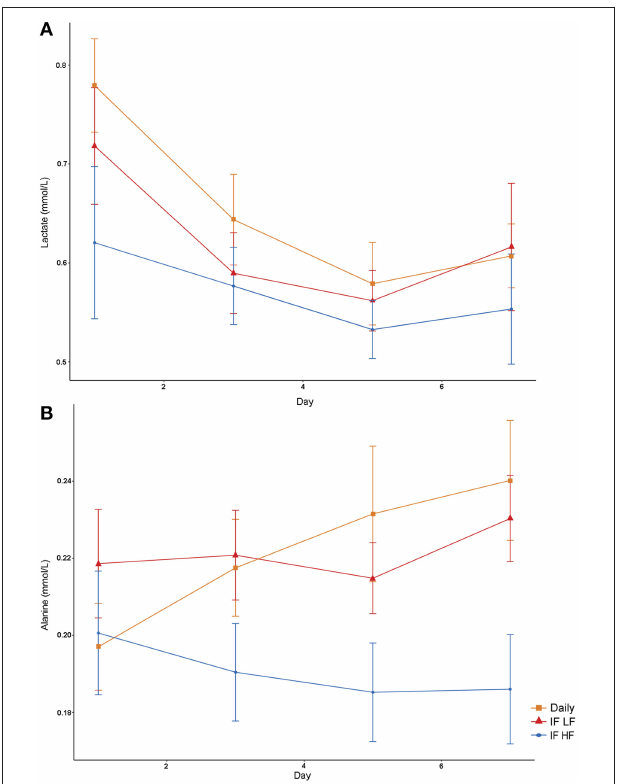
FIGURE 6 | Mean concentrations ( ± SE) of fasted plasma lactate (A) and alanine (B) in 10 dogs fed daily (square), and intermittently fasted on a low fat (triangle) and a high fat diet (circle) in a Latin Square design.